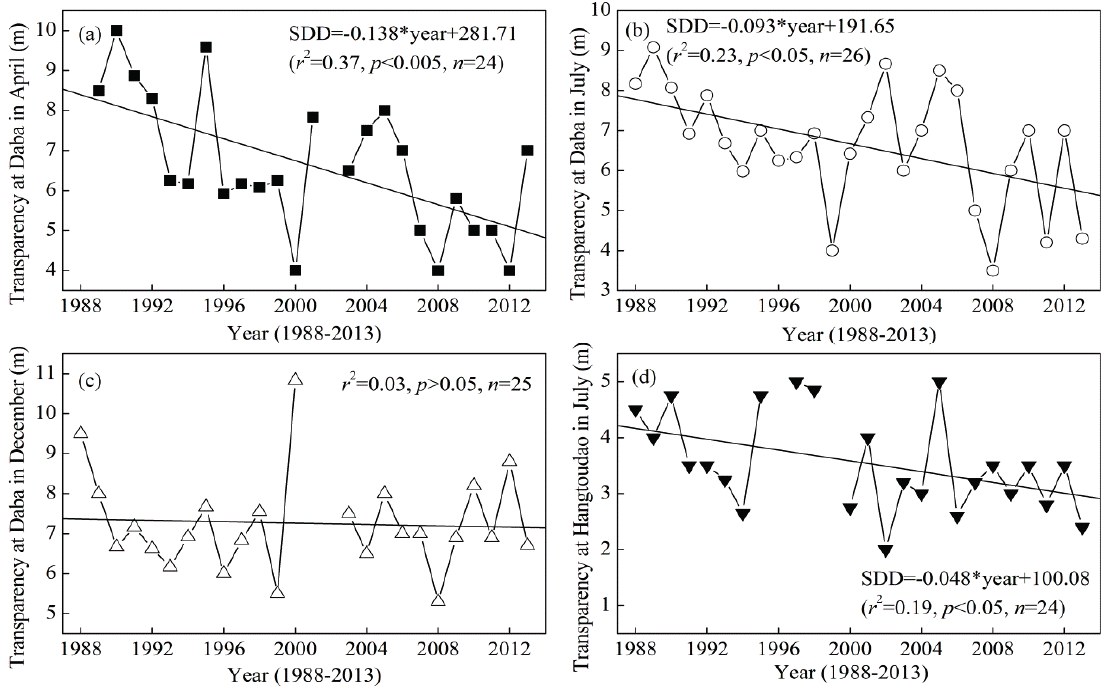
Figure 6. Long-term trends of transparency at Daba in April ( a ), July ( b ), and December ( c